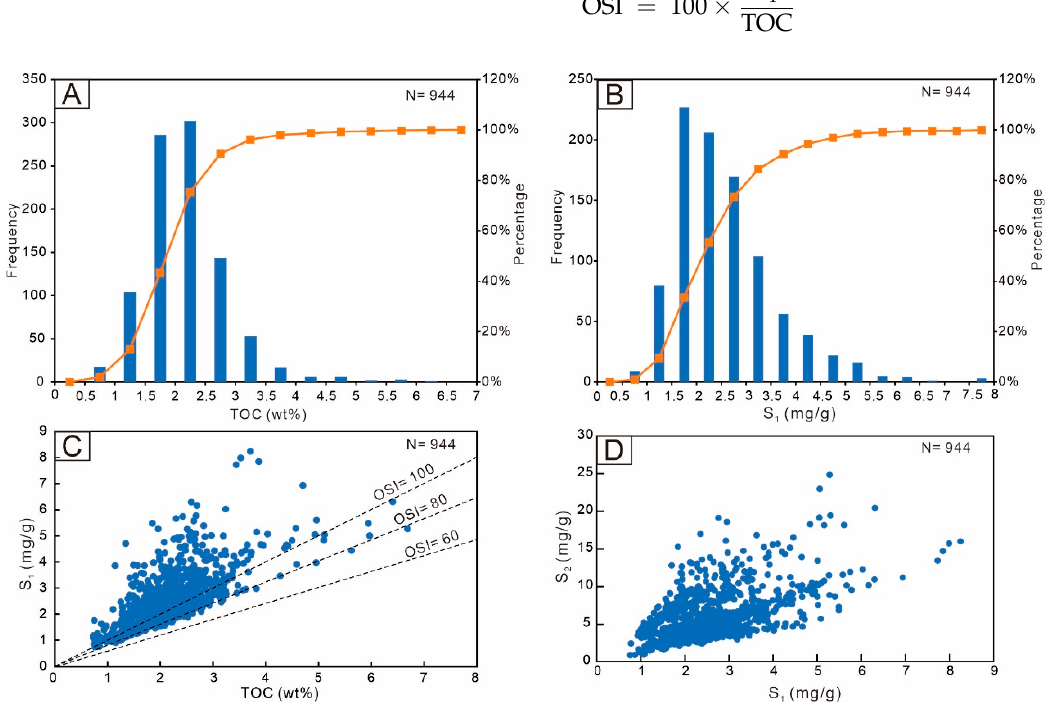
Figure 7. TOC and pyrolysis data showing the geochemical characteristics of FGSRs. ( A ) Histogram of the TOC values; ( B ) histogram of S 1 values; ( C ) cross plot showing the relationship between TOC and S 1 ; ( D ) cross plot showing the relationship between S 1 and S 2 .